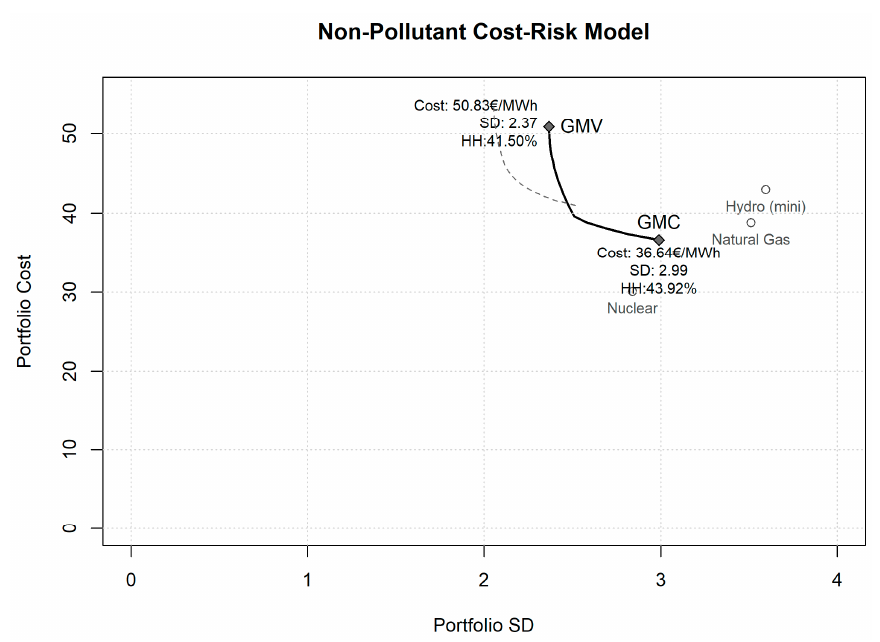
Figure 3. Non-pollutant technology model’s efficient frontier.